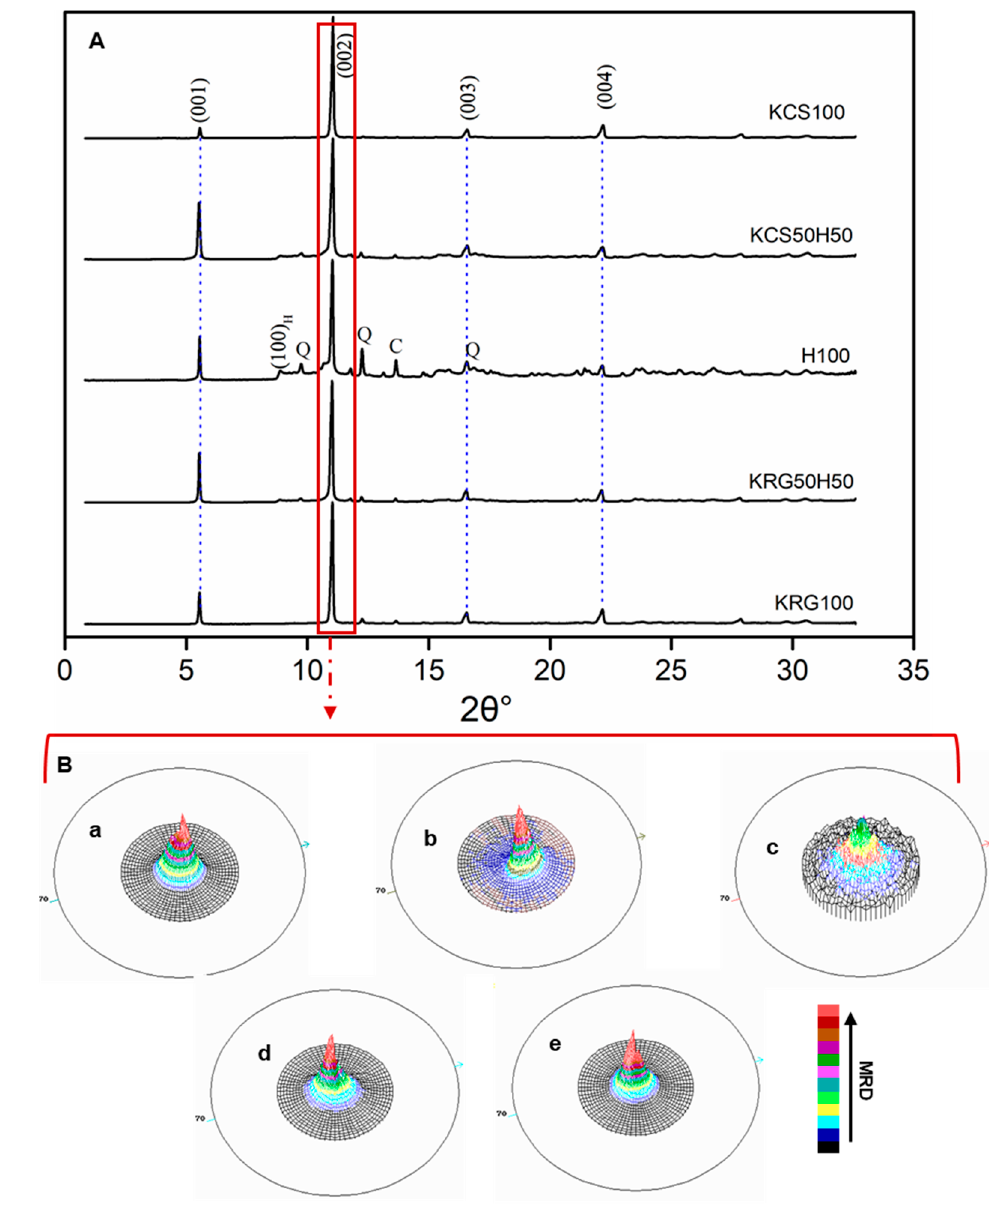
Figure 4. ( A ) XRD curves of green tapes samples. Kaolinite (JCPDS 00-005-0143), Halloysite (JCPDS 29-1487). ( B ) Pole figures of (002) reflexion peak of: ( a ) KRG100, ( b ) KRG50H50, ( c ) H100, ( d ) KCS50H50, and ( e ) KCS100 at 400 °C.